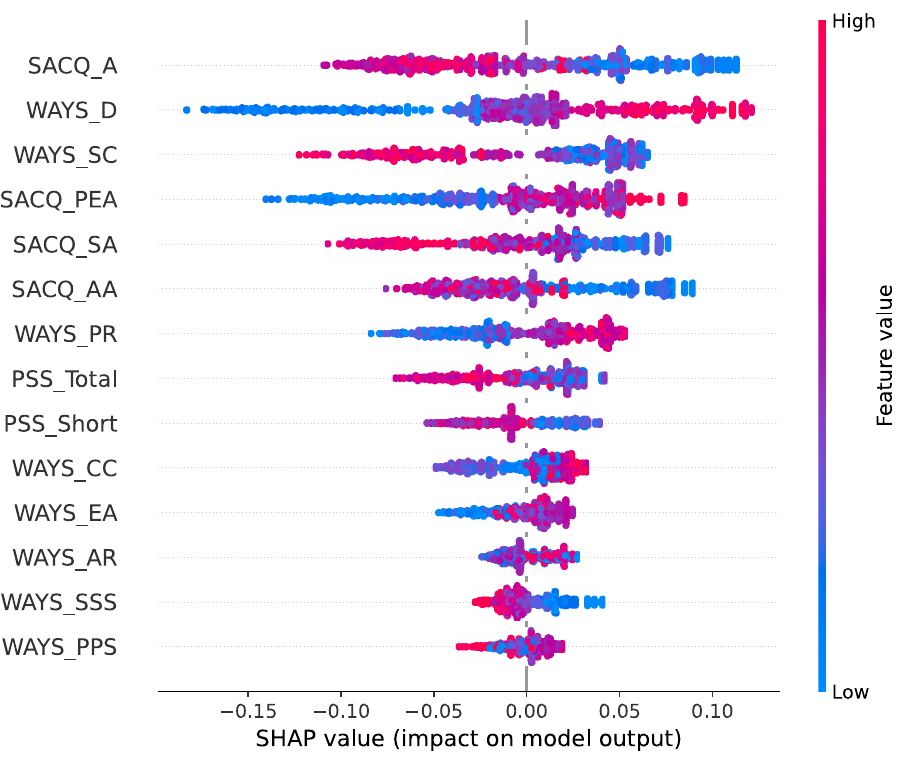
Fig 6. SHAP plot for discriminatory impact using the random forest model.